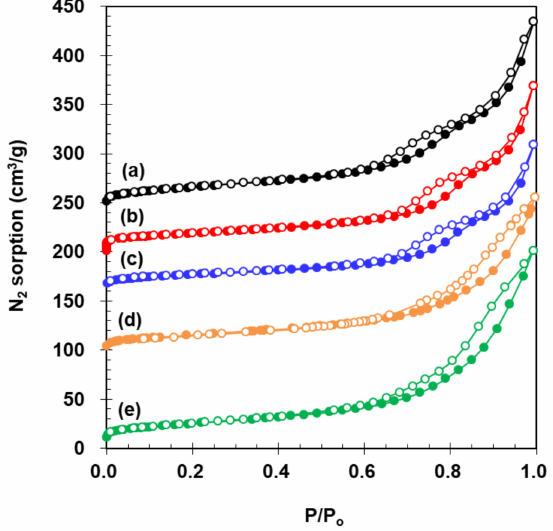
Figure 2. N 2 sorption isotherms on: ( a ) WT; ( b ) VWT; ( c ) 2.73% Fe 2 O 3 /VWT; ( d ) c-VWT; and ( e ) 2.73% Fe 2 O 3 /c-VWT.